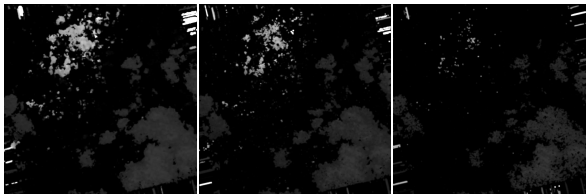
Figure 14. Derived cloud heights of test area Mch, 5 × 5 km 2 , scales 1, 2 and 4 resulting cloud heights above ground (heights 0–3000 m from black to white). The cloud heights seem to go down and up again following the depicted profile line from top left to bottom right. Figure 11. City center of Frankfurt am Main, 1500 × 1200 m 2 , left: multispectral epipolar image, right: merged heights above ground